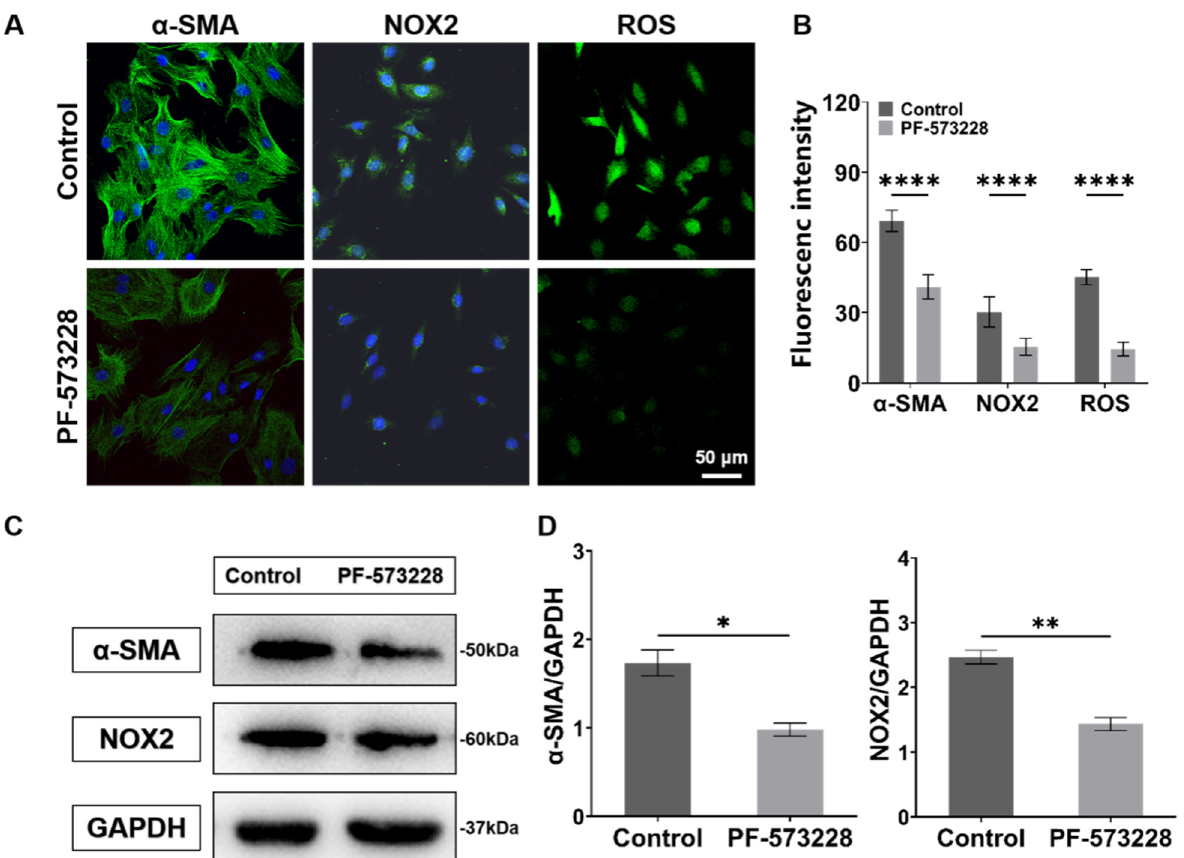
Figure 9. Characterization results of expressions of α -SMA, NOX2, and ROS of CFs on PA gels with PF-573228 intervention. ( A ) α -SMA, NOX2, and ROS fluorescence images of CFs with PF-573228 intervention. ( B ) Statistical histogram of fluorescence intensities of α -SMA, NOX2, and ROS ( n > 3). ( C ) Relative protein levels of α -SMA and NOX2 of CFs with PF-573228 intervention determined by western blotting analysis. ( D ) Statistical histogram of protein gray values of α -SMA and NOX2 ( n = 3). Data are shown as means ± SEM. * p < 0.05, ** p < 0.01, and **** p < 0.0001 determined by paired t -test.